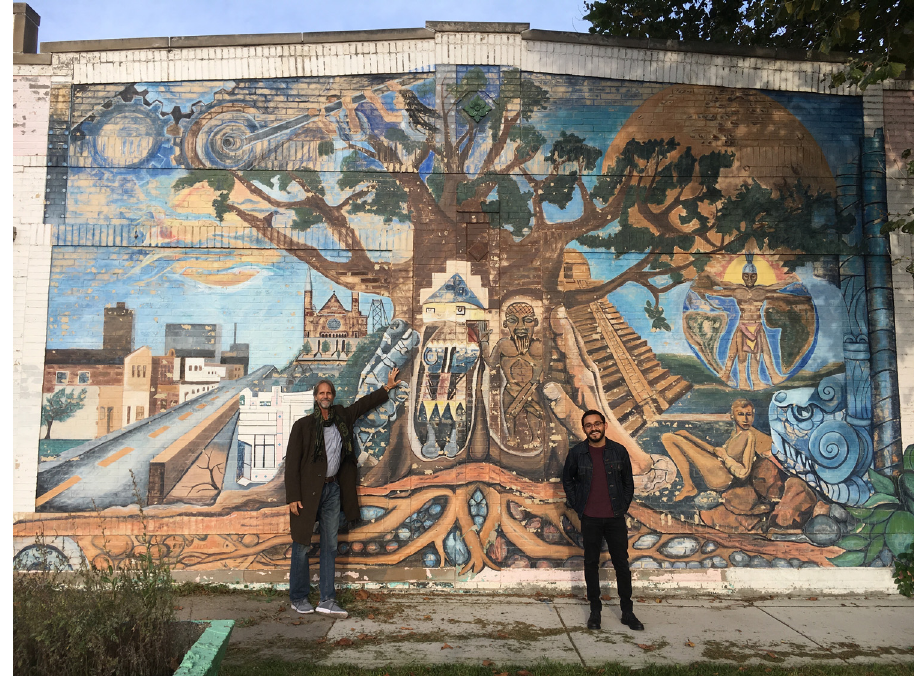
Figure 2: The mural “ City Spirit ” by George Vargas and Martin Moreno in Mexicantown, simbolizing the deep, rich integration of Latinos in Detroit with an image of the tree of life uniting the ancient roots of Latino culture with modern industrial Detroit. Jules Simon ( pointing to the tree ) and his student, Edgar